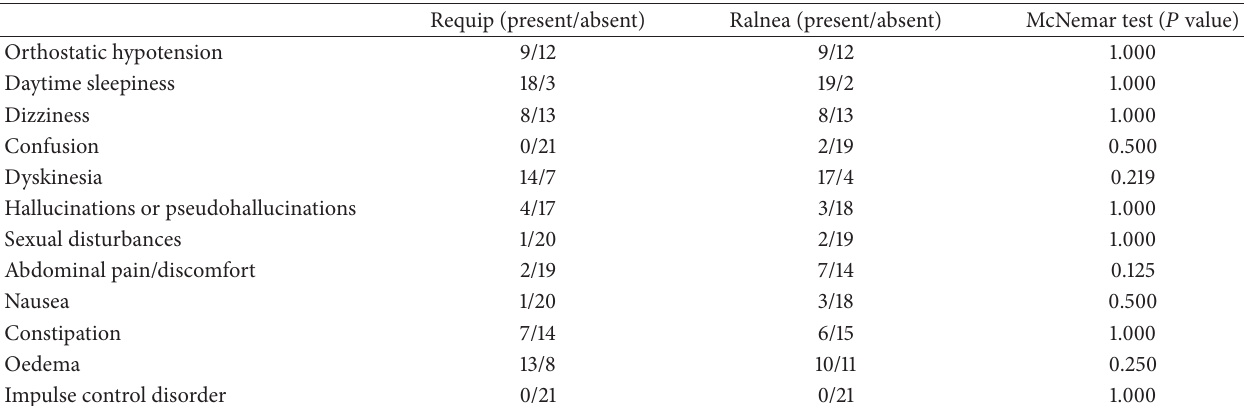
Table 2: Side-effect profile.